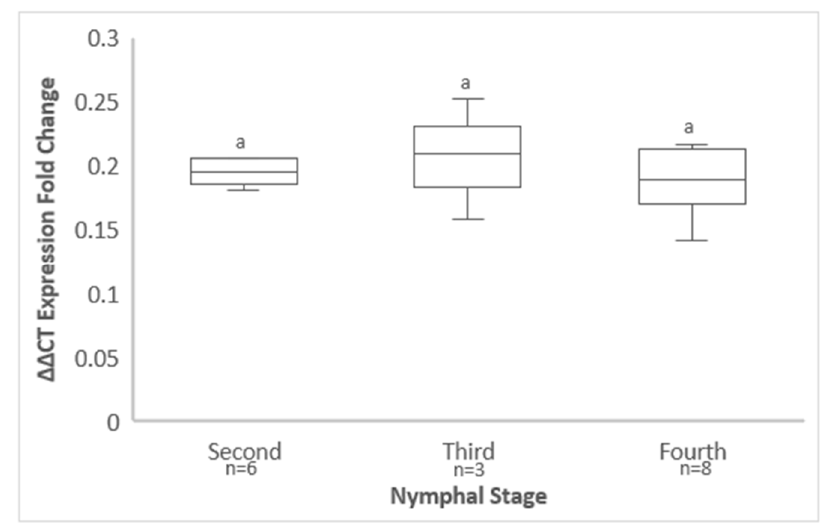
Figure 5. Quantification of grapevine red blotch virus (GRBV) by qPCR in Spissistilus festinus nymphal progeny born on GRBV-infected free-living vines, transferred to healthy, detached snap bean trifoliates as second, third, or fourth instars and tested upon emergence as adults. Error bars indicate standard error of the mean. Lowercase lettering indicating insignificant differences between ∆∆ Ct expression fold change values (2 ( − ∆∆ Ct) ), as determined by Tukey’s honestly significant difference test ( p < 0.05), are shown above standard error